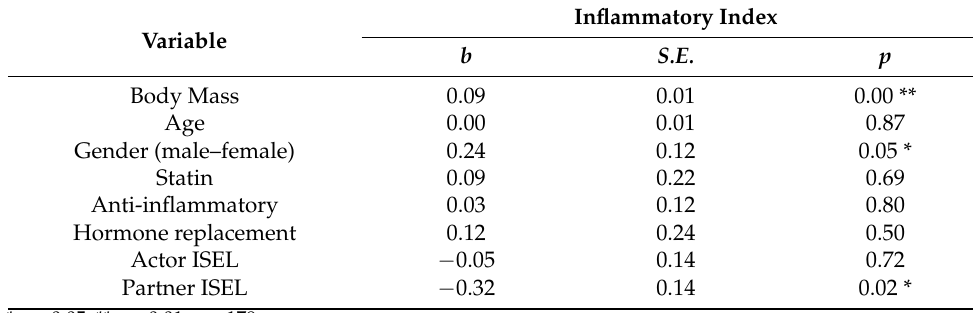
Table 3. Actor and partner perceived support and